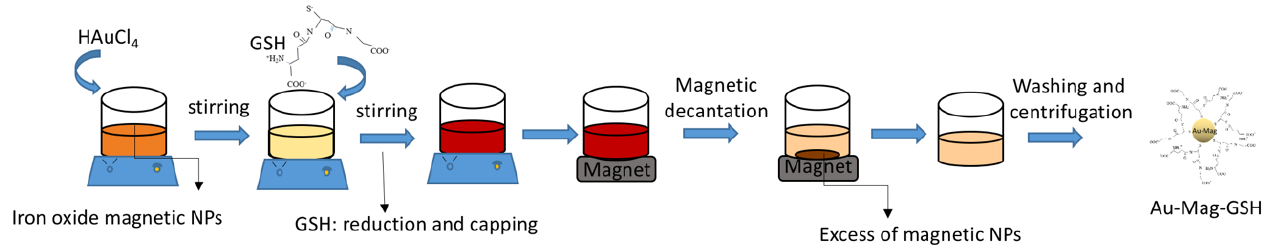
Figure 1. Diagram of the glutathione (GSH)-capped hybrid gold/iron oxide magnetic nanoparticles (NPs).